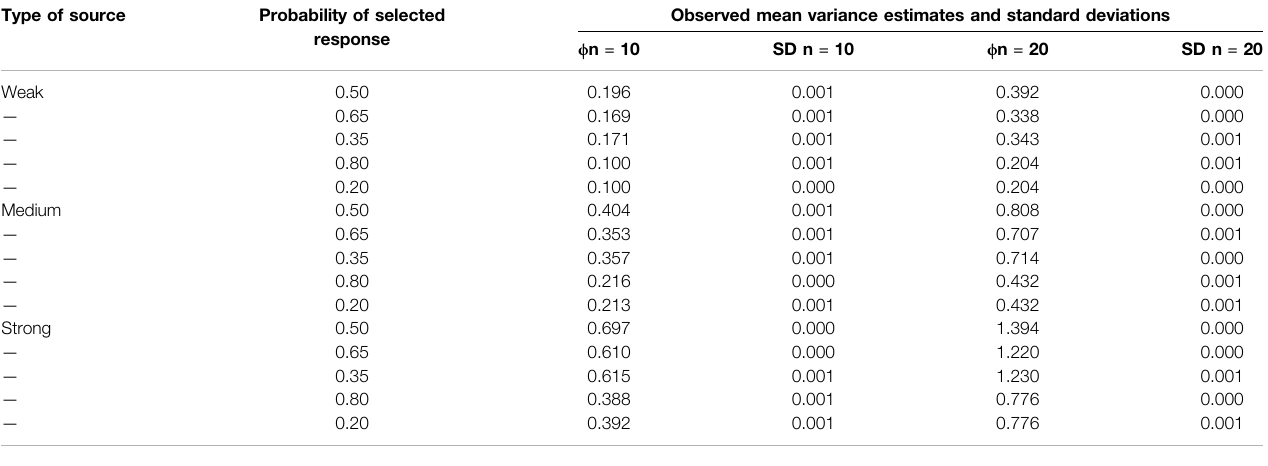
TABLE 3 | Mean Variance Estimates and Standard Deviations of Latent Variables Observed in Investigating Dichotomous Data for Datasets with 10 and 20 Columns (400 Datasets). Type of source Probability of selected response